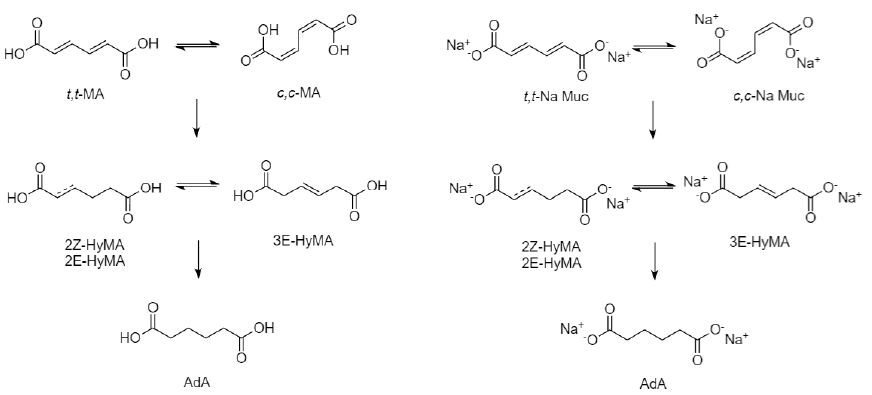
Figure 2. Scheme of MA ( left ) and Na-muconate ( right ) conversion to AdA.